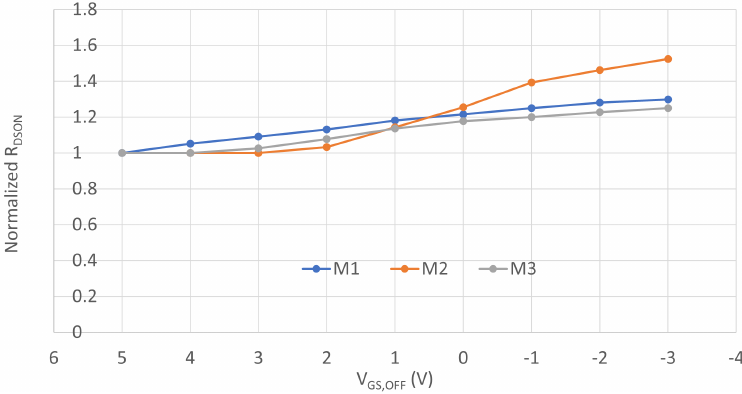
Figure 9. Normalized R DS , ON vs. V gs , OFF for M1, M2, and M3